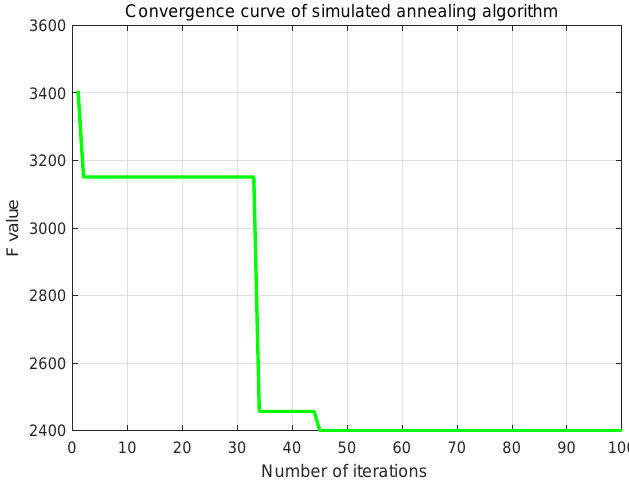
Figure 3. Correspondence between iterative process and F